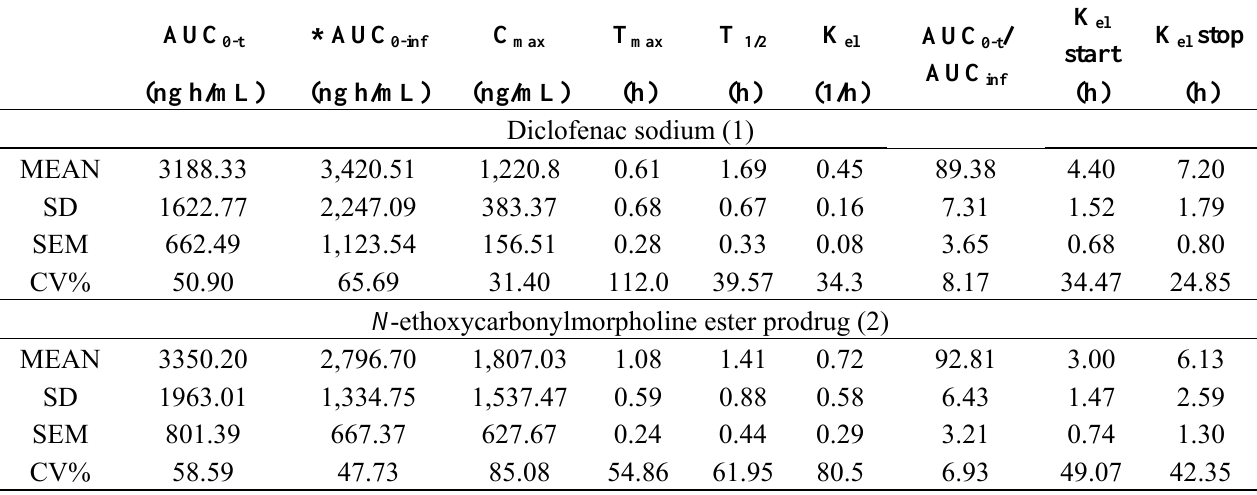
the prodrug ( 2 ). None of the pharmacokinetic parameters of the prodrug ( 2 ) was